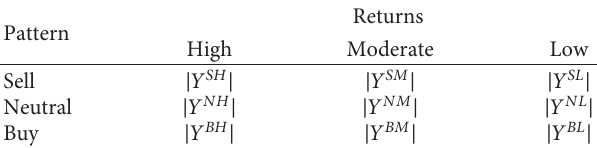
Table 2: 2-dimensional frequency